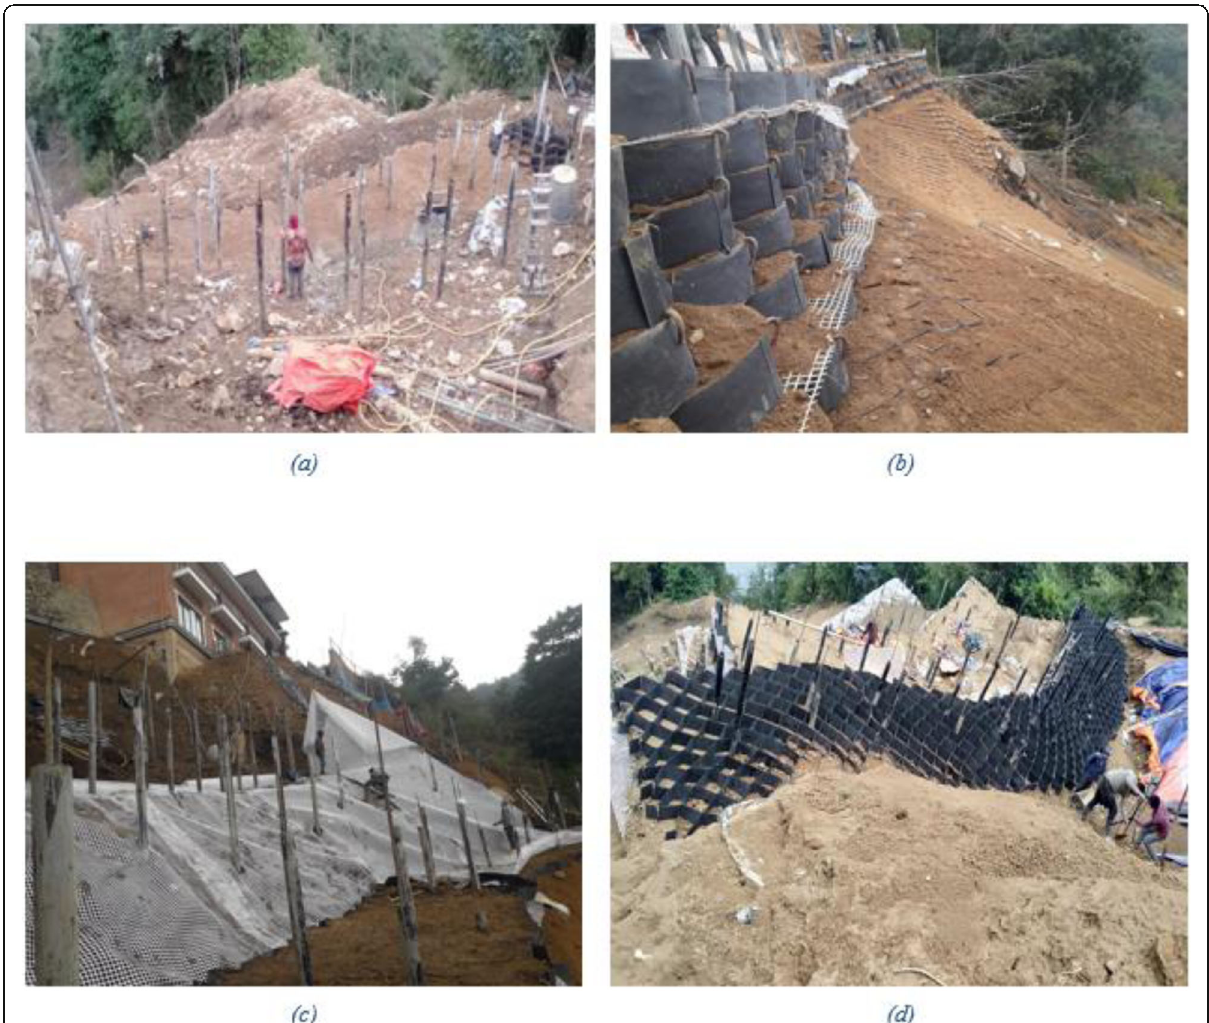
Fig. 8 a Installation of micropile, b Geocell wall, c Laying of geogrid inside the micropile in slope area for stable of back fill materials soil, d Laying of geocell wall inside